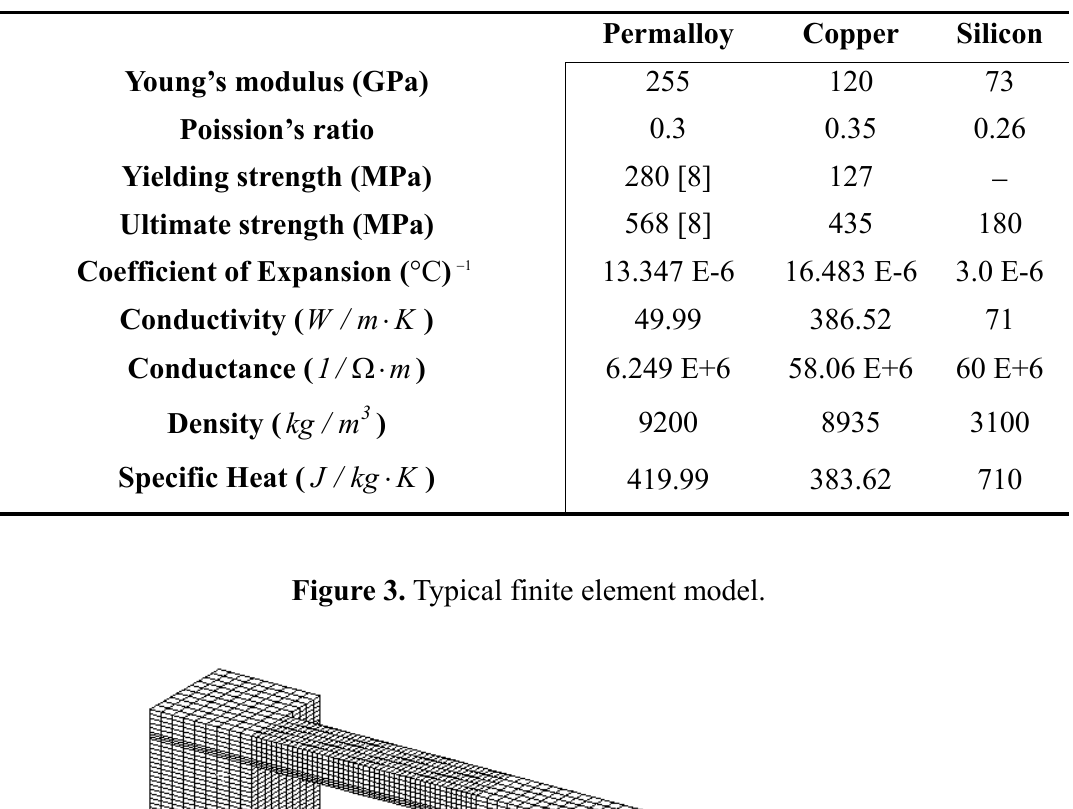
Table 1. Mechanical, electrical and physical properties used in finite element simulations.